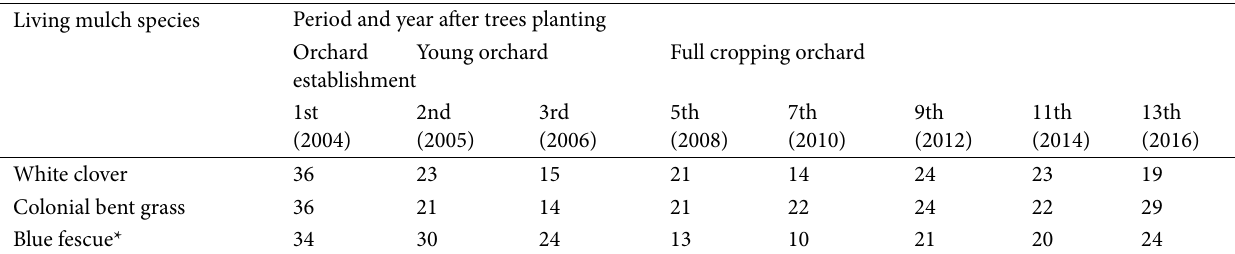
Table 3 Number of the identified weed taxa on the soil surface in the tree rows with the living mulch sod, in the succeeding years 2004 −